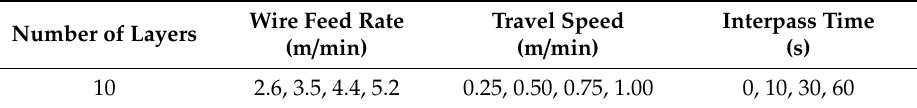
Table 2. Process parameters of the WAAM